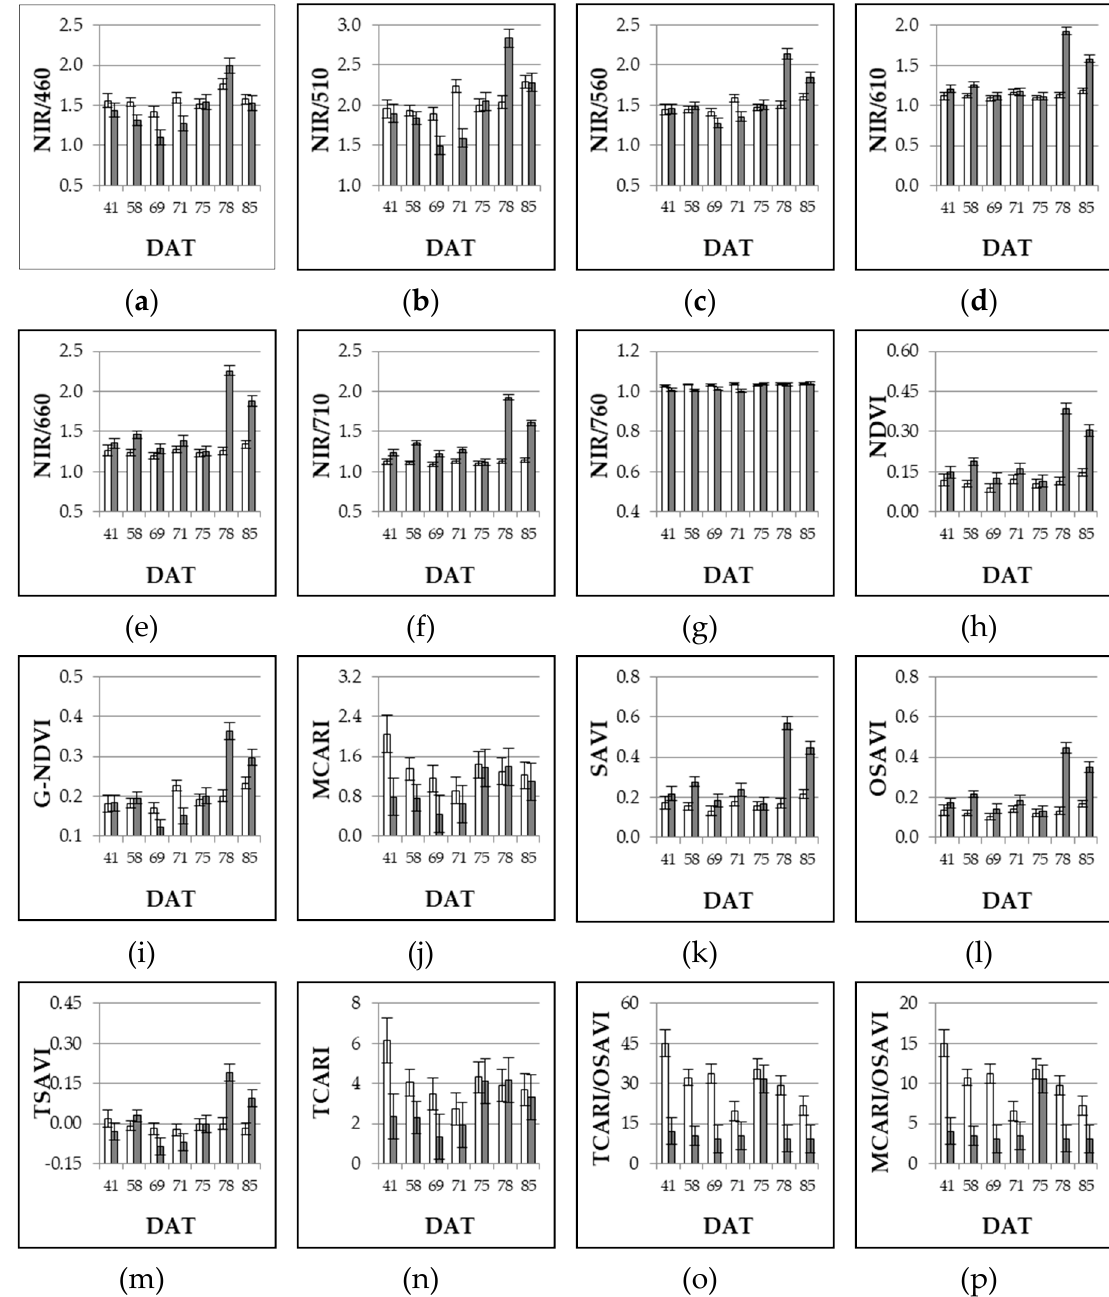
Figure 2. Experiment 2#. Influence of bare soil (white bars) and black mulching film (grey bars) on different VIs as assessed throughout the growing season (41, 58, 69, 71, 75, 78, 85 DAT). DAT = days after transplanting. Mean values ± SE.